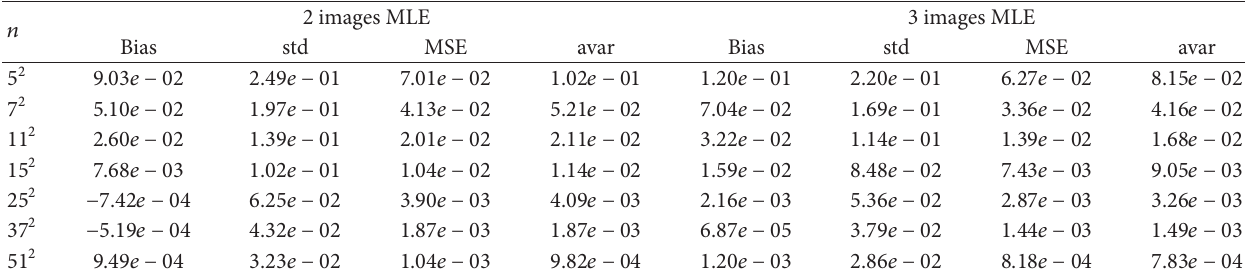
Table 3: Simulation results for the estimation of 𝑃 2 using 2 or 3 images, obtained from 1000 Monte-Carlo runs (matrix Γ 2 ). 𝑛 2 images MLE 3 images MLE Bias std MSE avar Bias std MSE avar